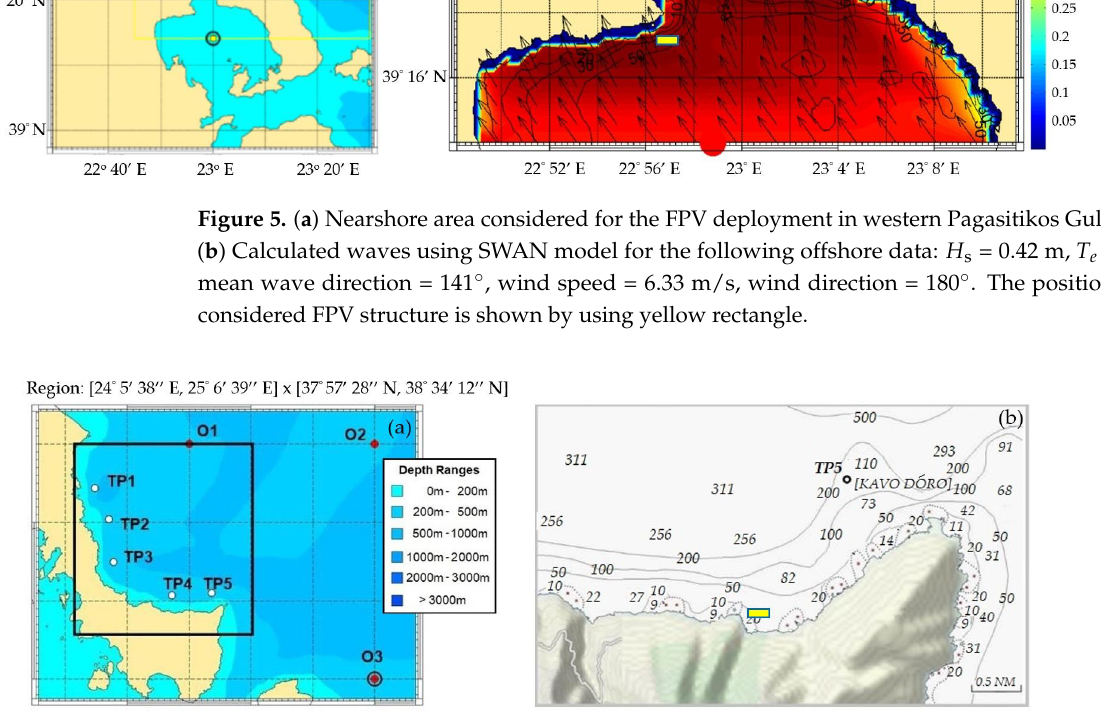
Figure 6. Nearshore area considered for the FPV deployment in SE region of Evia Island. The position of the considered FPV structure is shown using yellow rectangle.